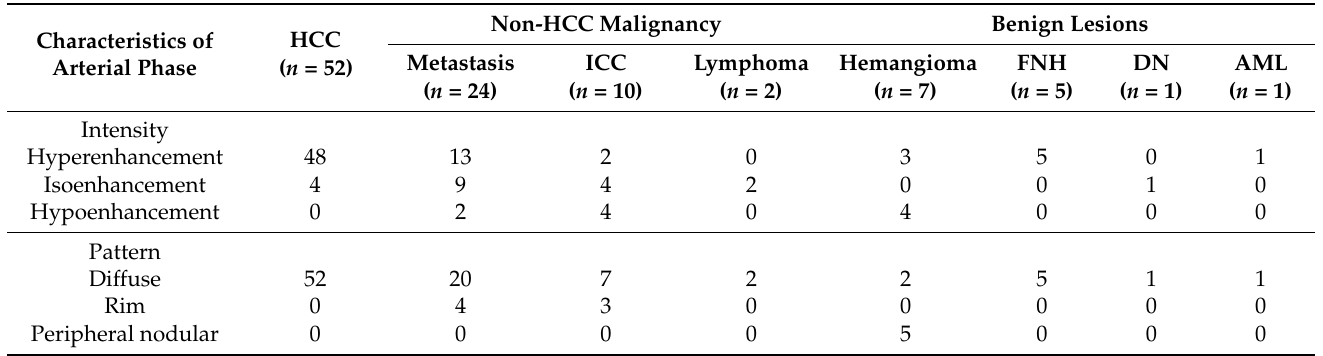
Table 3. Arterial phase